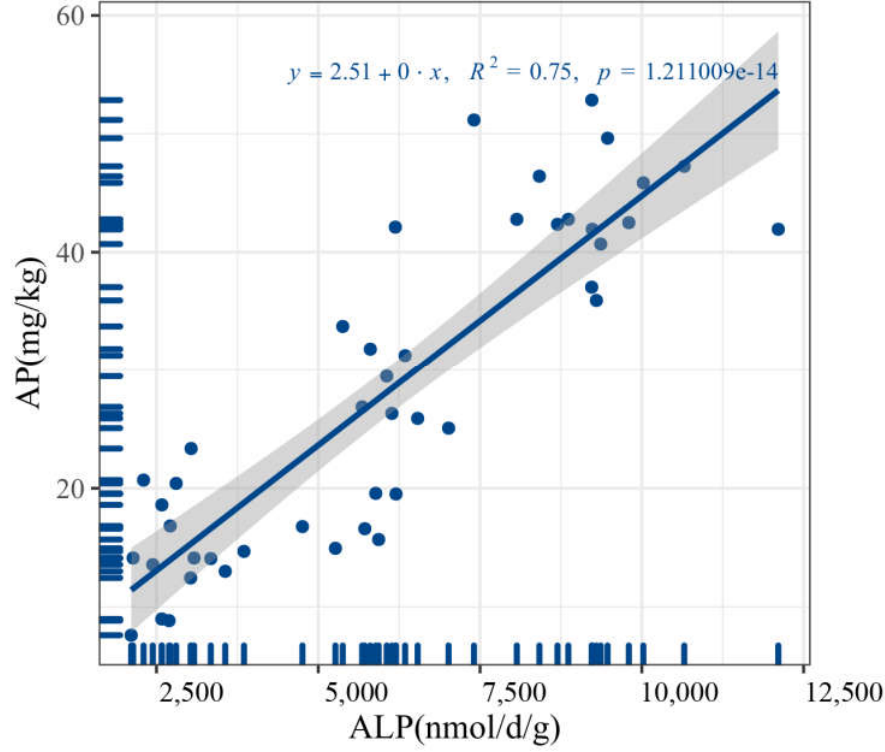
Figure 8. Scatter diagram between soil alkaline phosphatase activity and available phosphorus.